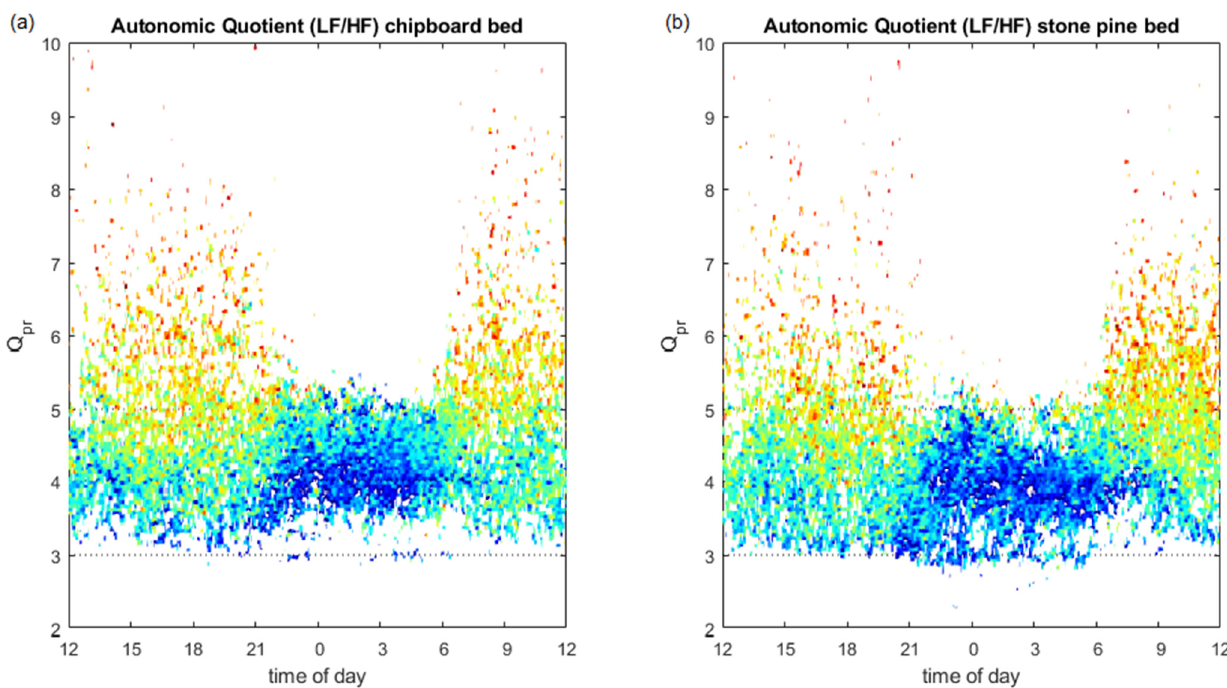
Figure 6. Average of autonomic quotient (LF/HF, colour coded: red = sympathetic predominance, blue = vagal predomi- nance) over the time of day (abscissa) and pulse–respiration quotient (Qpr, ordinate), when the subjects slept in the stone pine wood beds ( b ) and in the chipboard beds ( a ). The Qpr is higher during the day and approaches a relation of four heartbeats per respiratory cycle during the night. A whole number Qpr of 4:1 and 3:1 is coincident with an especially low autonomic quotient (coded in blue), indicating strong vagal predominance. The 4:1 period of Qpr with stronger vagal predominance lasts two hours longer during and after sleeping in the stone pine bed ( b ), indicating a longer period of phase coupling for cardiorespiratory interactions (CRIs) in this type of bed.